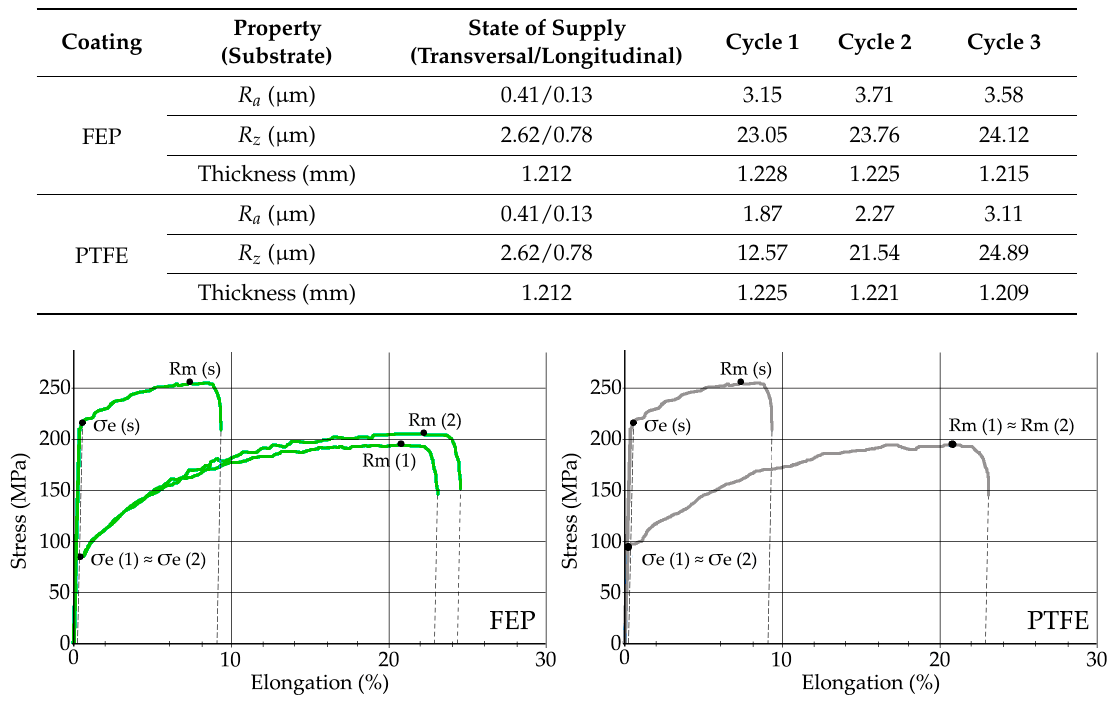
Figure 8. Stress–elongation (%) graphics of substrate coated by FEP and PTFE: (s) state of supply, (1) after removal-coating cycle 1, (2) after removal-coating cycle 2.